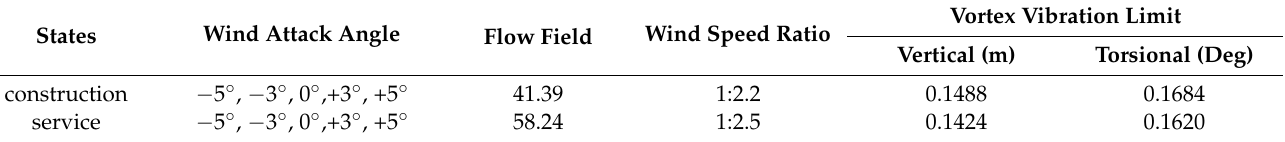
Table 3. Test conditions and limit